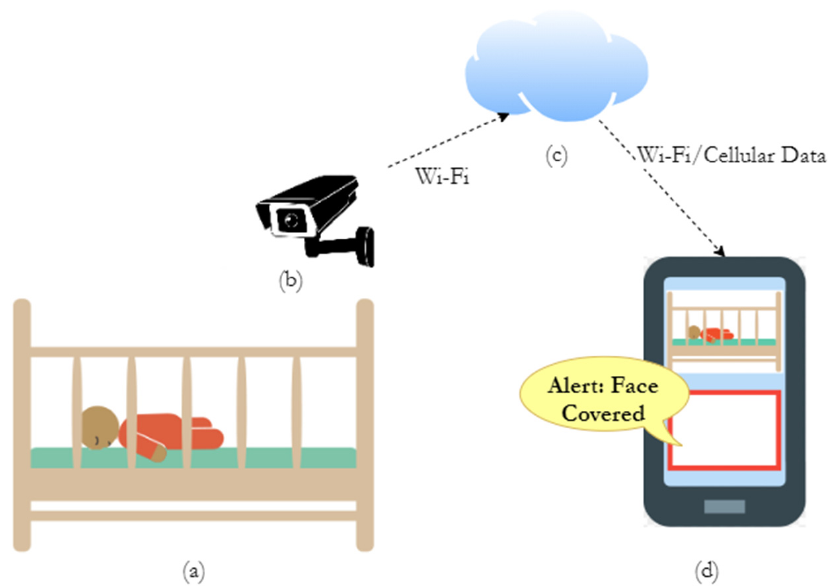
Figure 1. The overall smart baby monitoring system: ( a ) baby sleeping; ( b ) smart baby monitoring device automatically detects harmful postures such as face covered, thrown off the blanket, frequently moving or awake; ( c ) image data are sent to the smartphone through the Internet with the message of any harmful situation; ( d ) a real-time video of the baby is shown in the smartphone, and notifications and alerts are generated whenever the caregiver receives a message of the harmful situation of the baby.